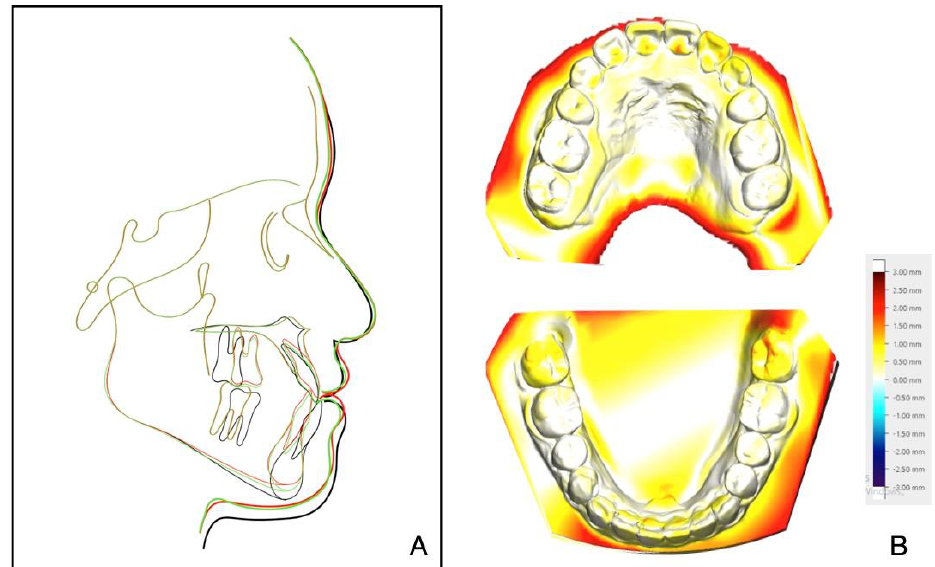
Figure 11. ( A ) Superimposed cephalometric tracings: pretreatment (black), posttreatment (red), and 8-year follow-up (green). ( B ) Superimposition of the posttreatment and retention digital dental models.